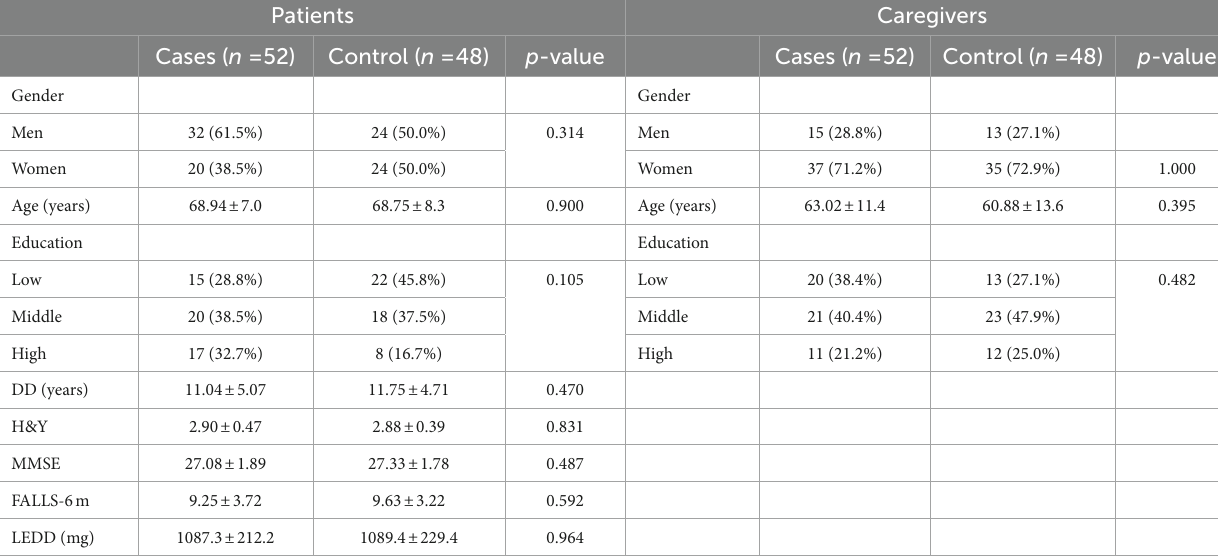
TABLE 1 Demographic and baseline characteristics of subjects in the intervention and in the control group.